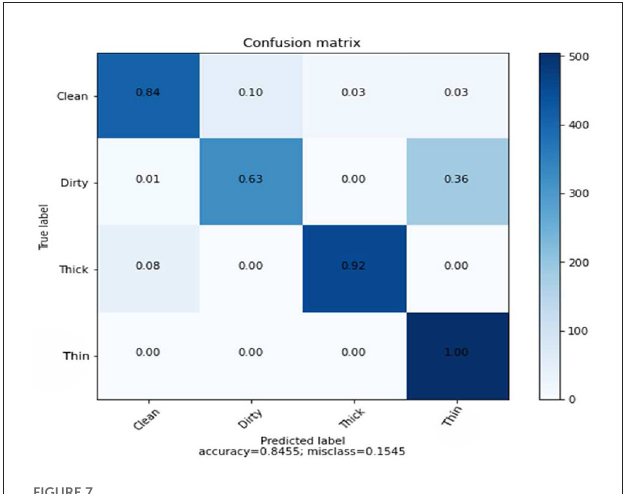
FIGURE7 Confusion matrix of combined features using SVM.